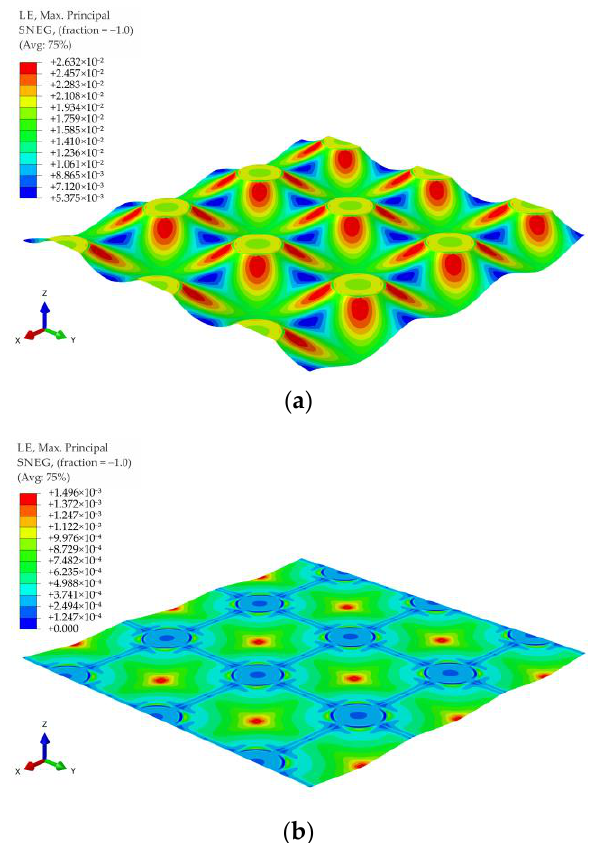
Figure 33. Deformation and maximum principal strain in reinforcement for pyramid shape load distribution, variant B2: ( a ) k = 0 kN/m 3 ; ( b ) k = 500 kN/m 3 .